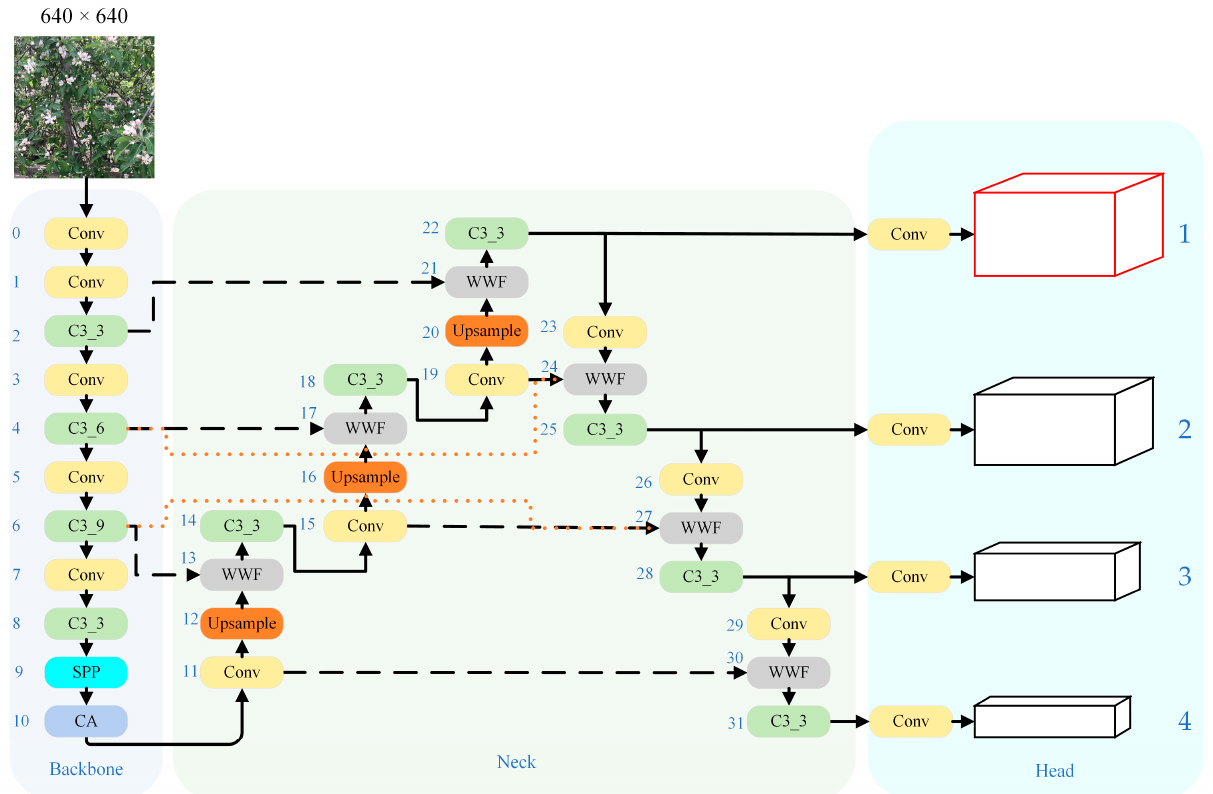
Figure 9. Improved YOLOv5s network structure. The number to the left of each layer of the network is used to mark the number of the layer. The coordinate attention layer is inserted into the back end of the backbone network. A small object detection layer of size 80 × 80 is added, located in the 1st detection head. The features in layers 7 and 6 are weighted fused with the features in layers 24 and 27, respectively, and WFF denotes the weighted feature fusion